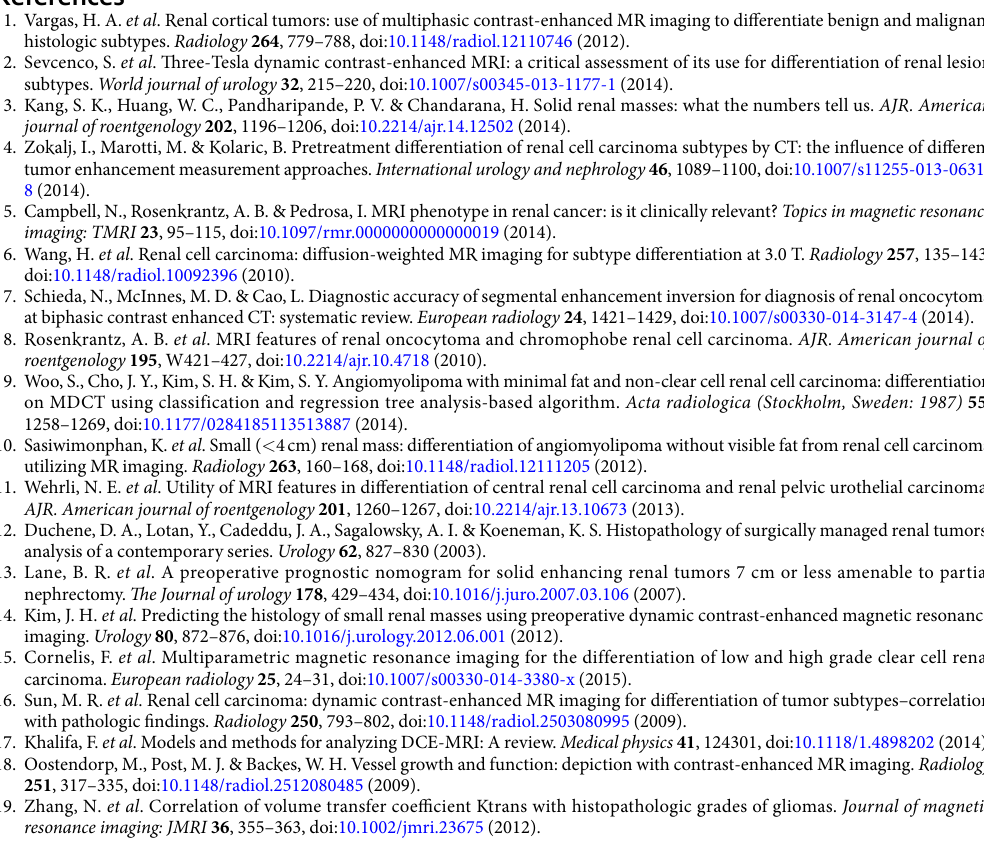
8 Scientific RepoRts | 7: 3117 | DOI:10.1038/s41598-017-03376-7